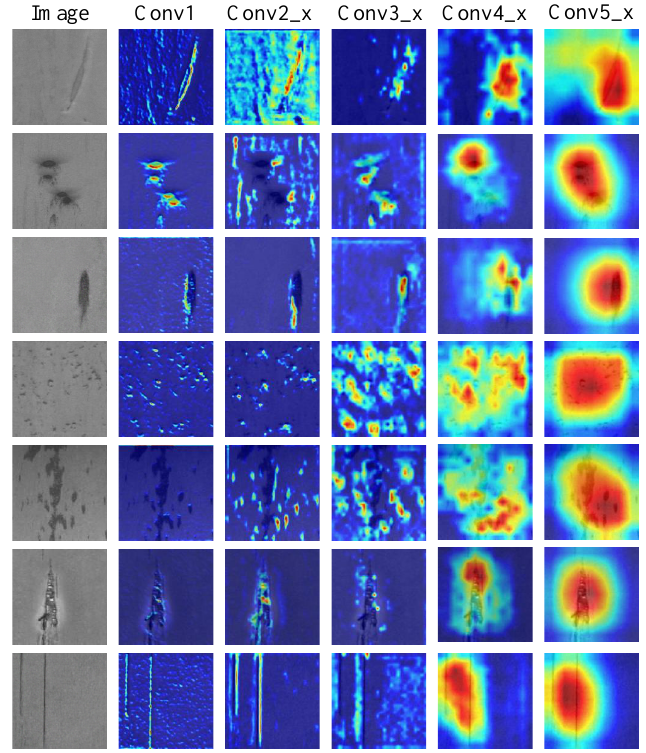
Figure 10. Feature visualization heat